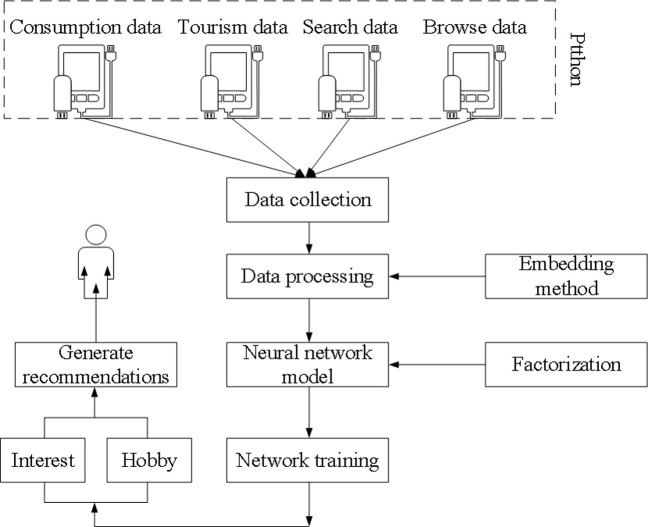
Process of deep learning CNN.